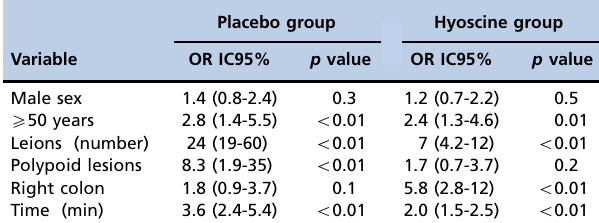
Table 3 - Logistic regression analysis of the adenoma detection rate. Placebo